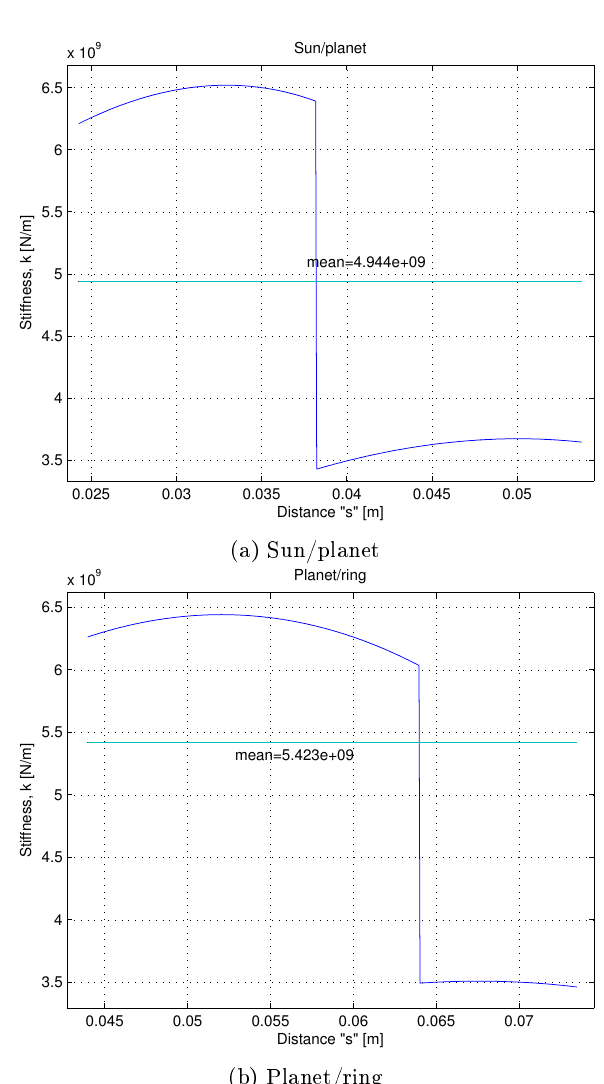
Figure 7: Sti(cid:27)ness as a function of the base circle arc length s (cyclic dependence).